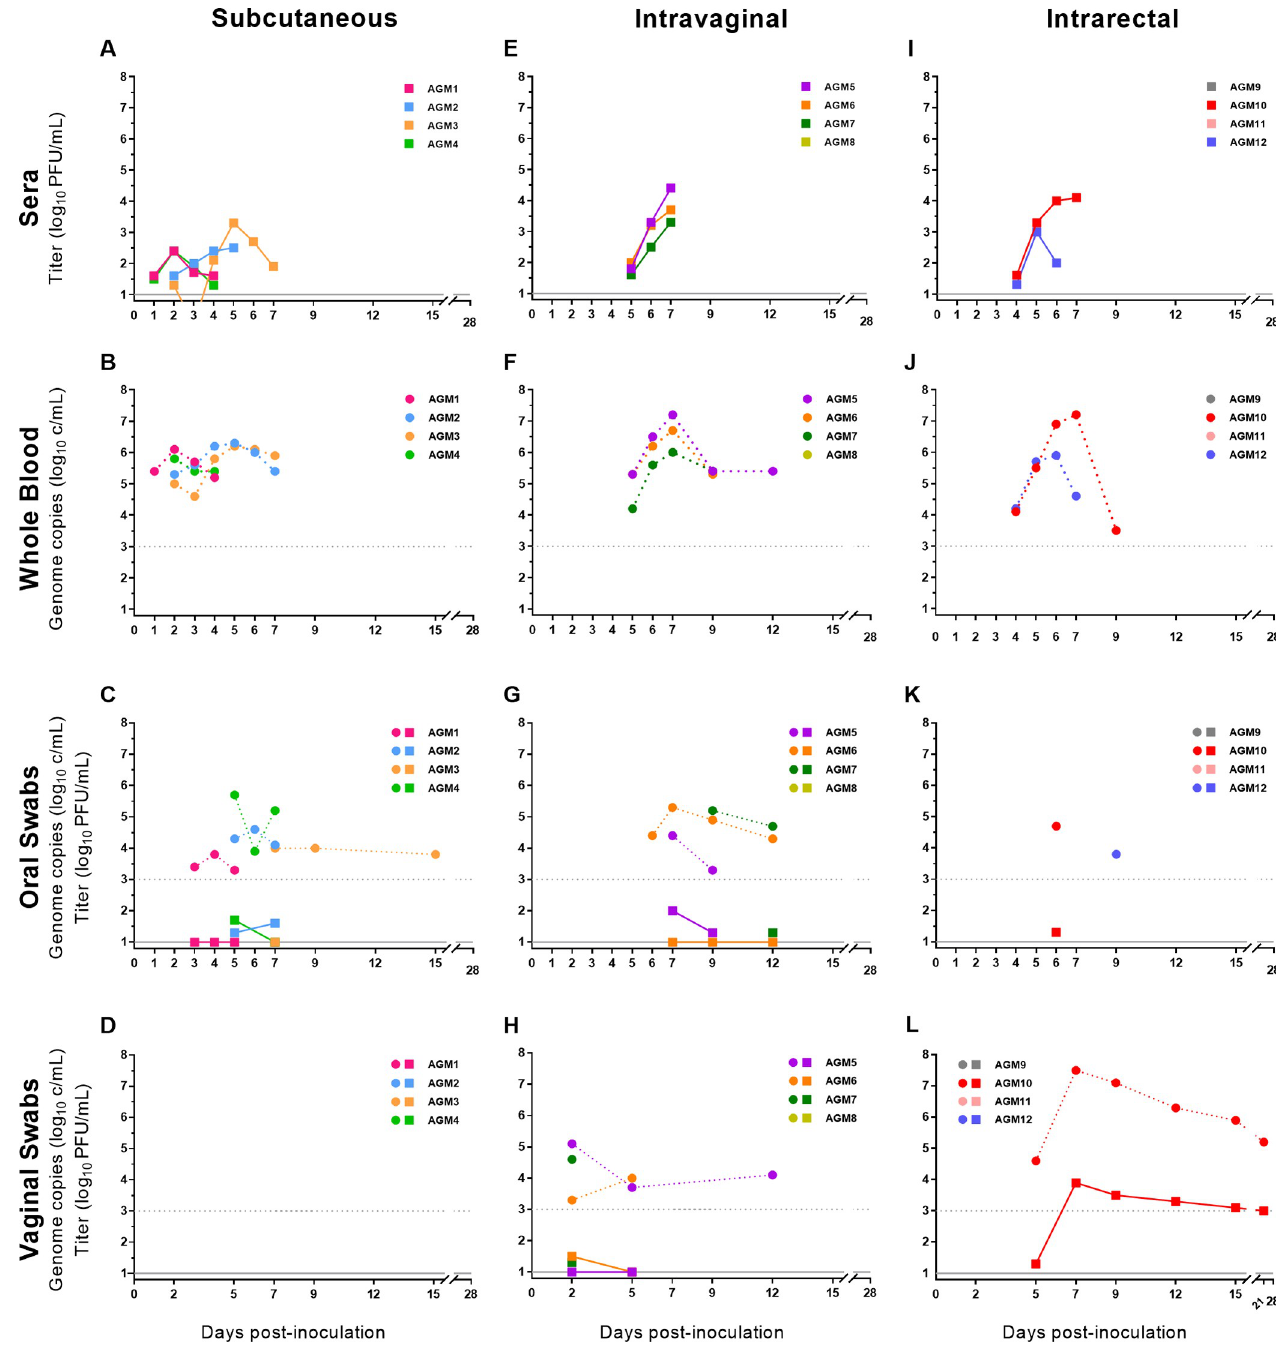
Fig 2. Viremia and viral RNA detected in bodily fluids by day post-inoculation. Viremia and viral RNA detected in subcutaneously inoculated African green monkeys (panel A, B, C and D); intravaginally inoculated African green monkeys (panel E, F, G and H); intrarectally inoculated African green monkeys (panel I, J, K and L). Circles and/or dotted lines connecting points represent genome copies in log 10 c/mL. Squares and/or solid lines connecting points represent virus titers in log 10 PFU/mL. The lower limit of detection for genome copies was 3.0 log 10 c/mL. The lower limit of detection for virus titers was 1.0 log 10 PFU/mL.